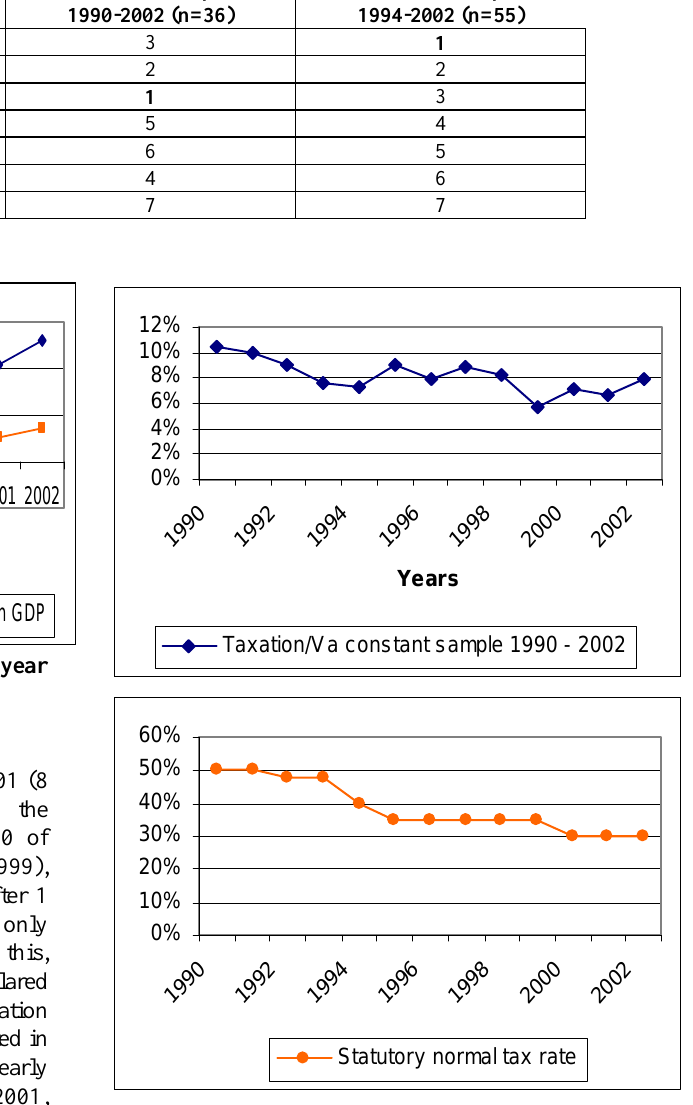
Figure 2: Trends in tax rates and the ratio